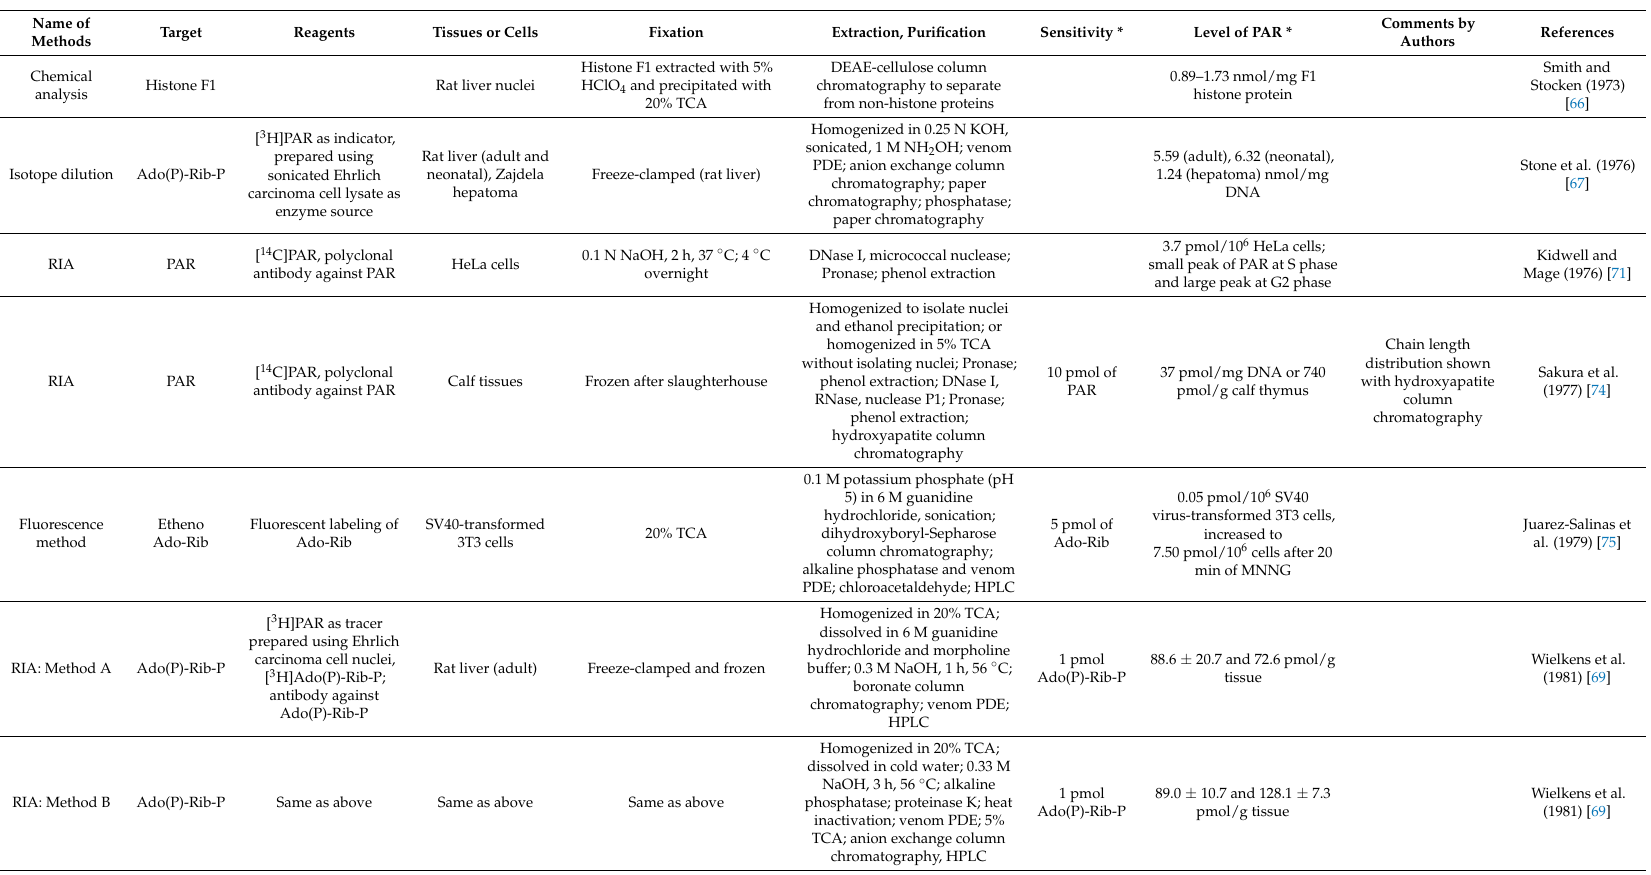
Table 1. In vivo level of PAR assayed by various